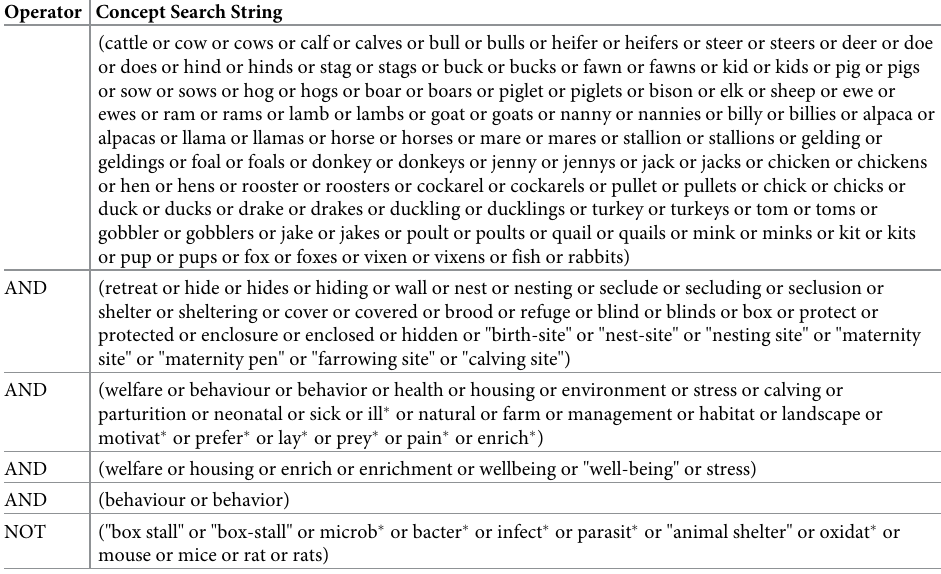
Table 1. Algorithm for database search. Operator Concept Search